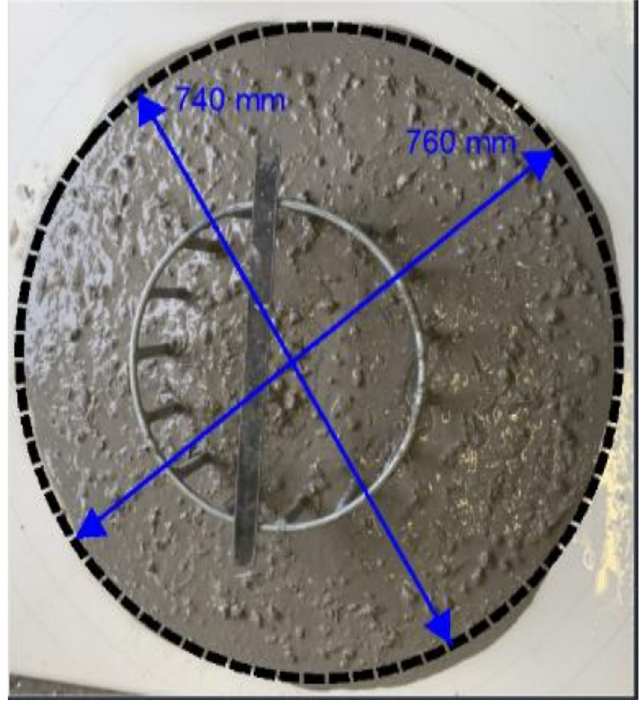
Figure 4. Slump flow test done in conjunction with J-ring